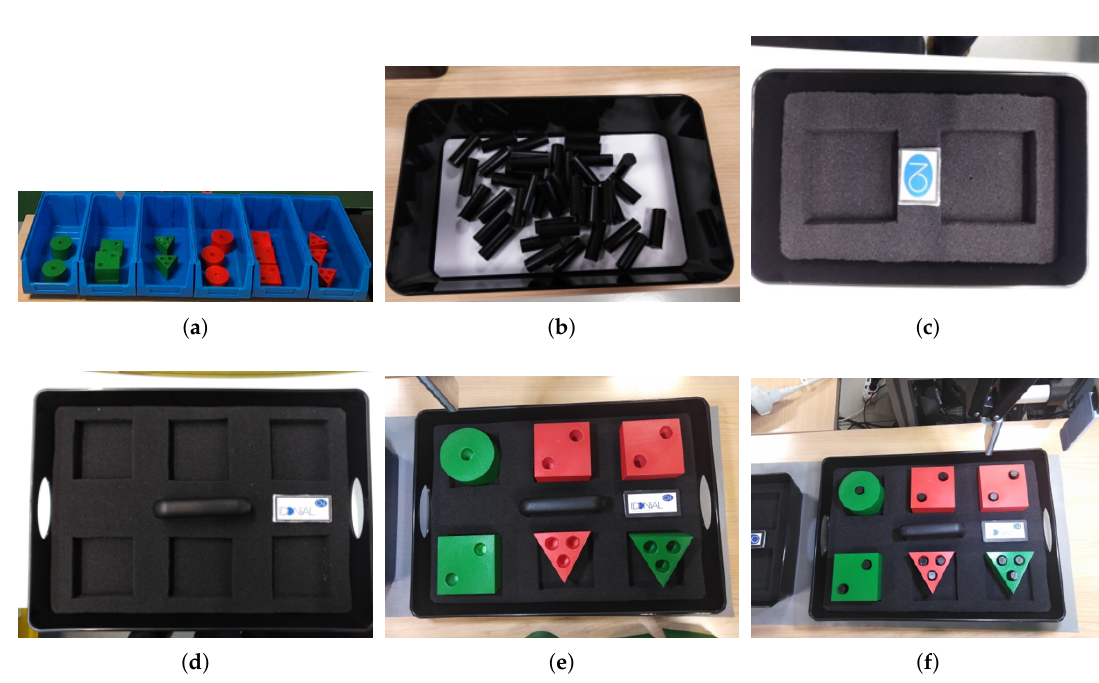
Figure 12. Detailed view of the use case components: ( a ) parts in the containers, ( b ) covers, ( c ) buffer, ( d ) empty tray, ( e ) parts in a tray, and ( f ) completed